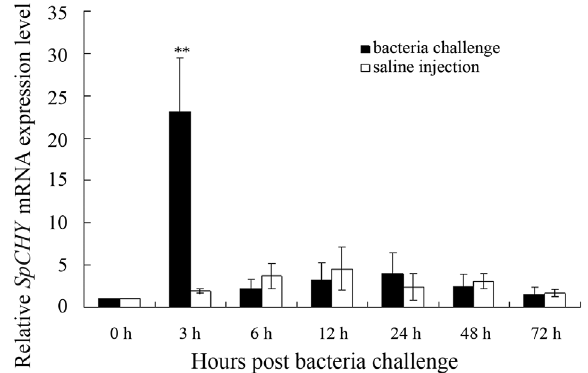
Figure 6 - Transcript profiles of SpCHY in hepatopancreas of S. paramamosain following challenge with V. alginolyticus ,. The relative SpCHY transcript levels in crabs challenged with V. alginolyticus were compared to those of saline injected animals. The expression of a (cid:3) -actin gene was used as endogenous control. Significant differences of SpCHY expression between the challenged and the control group are indicated with asterisks. **p <